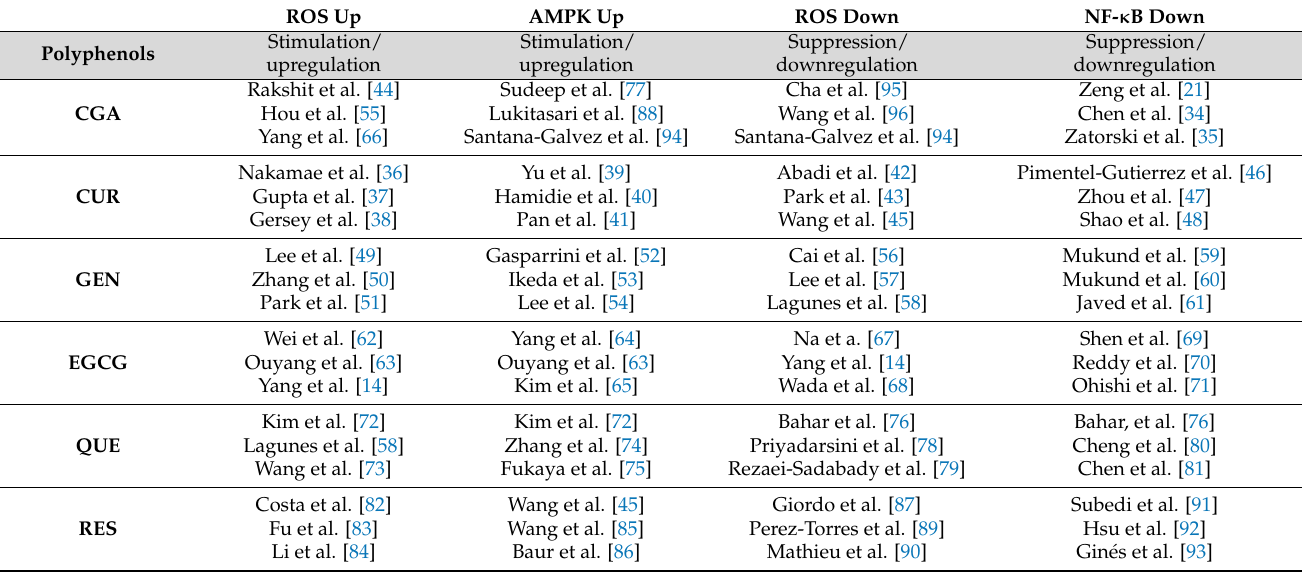
Table 2. Modulatory effects of CGA, CUR, GEN, EGCG, QUE, and RES on ROS, AMPK, and NF- κ B. ROS Up AMPK Up